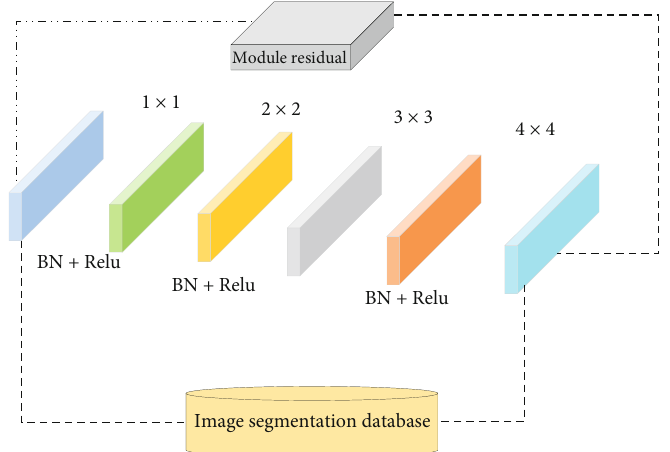
Figure 4: Schematic diagram of the residual